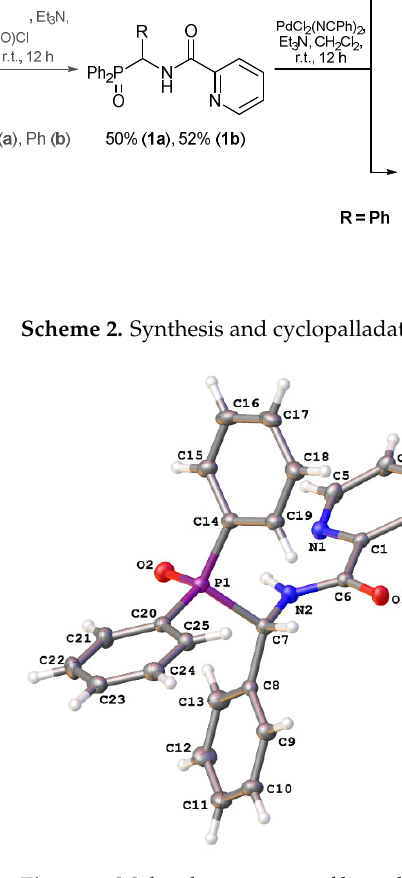
Figure 2. Molecular structure of ligand 1b . Hereinafter, the atoms are drawn as thermal ellipsoids at 40% probability level.